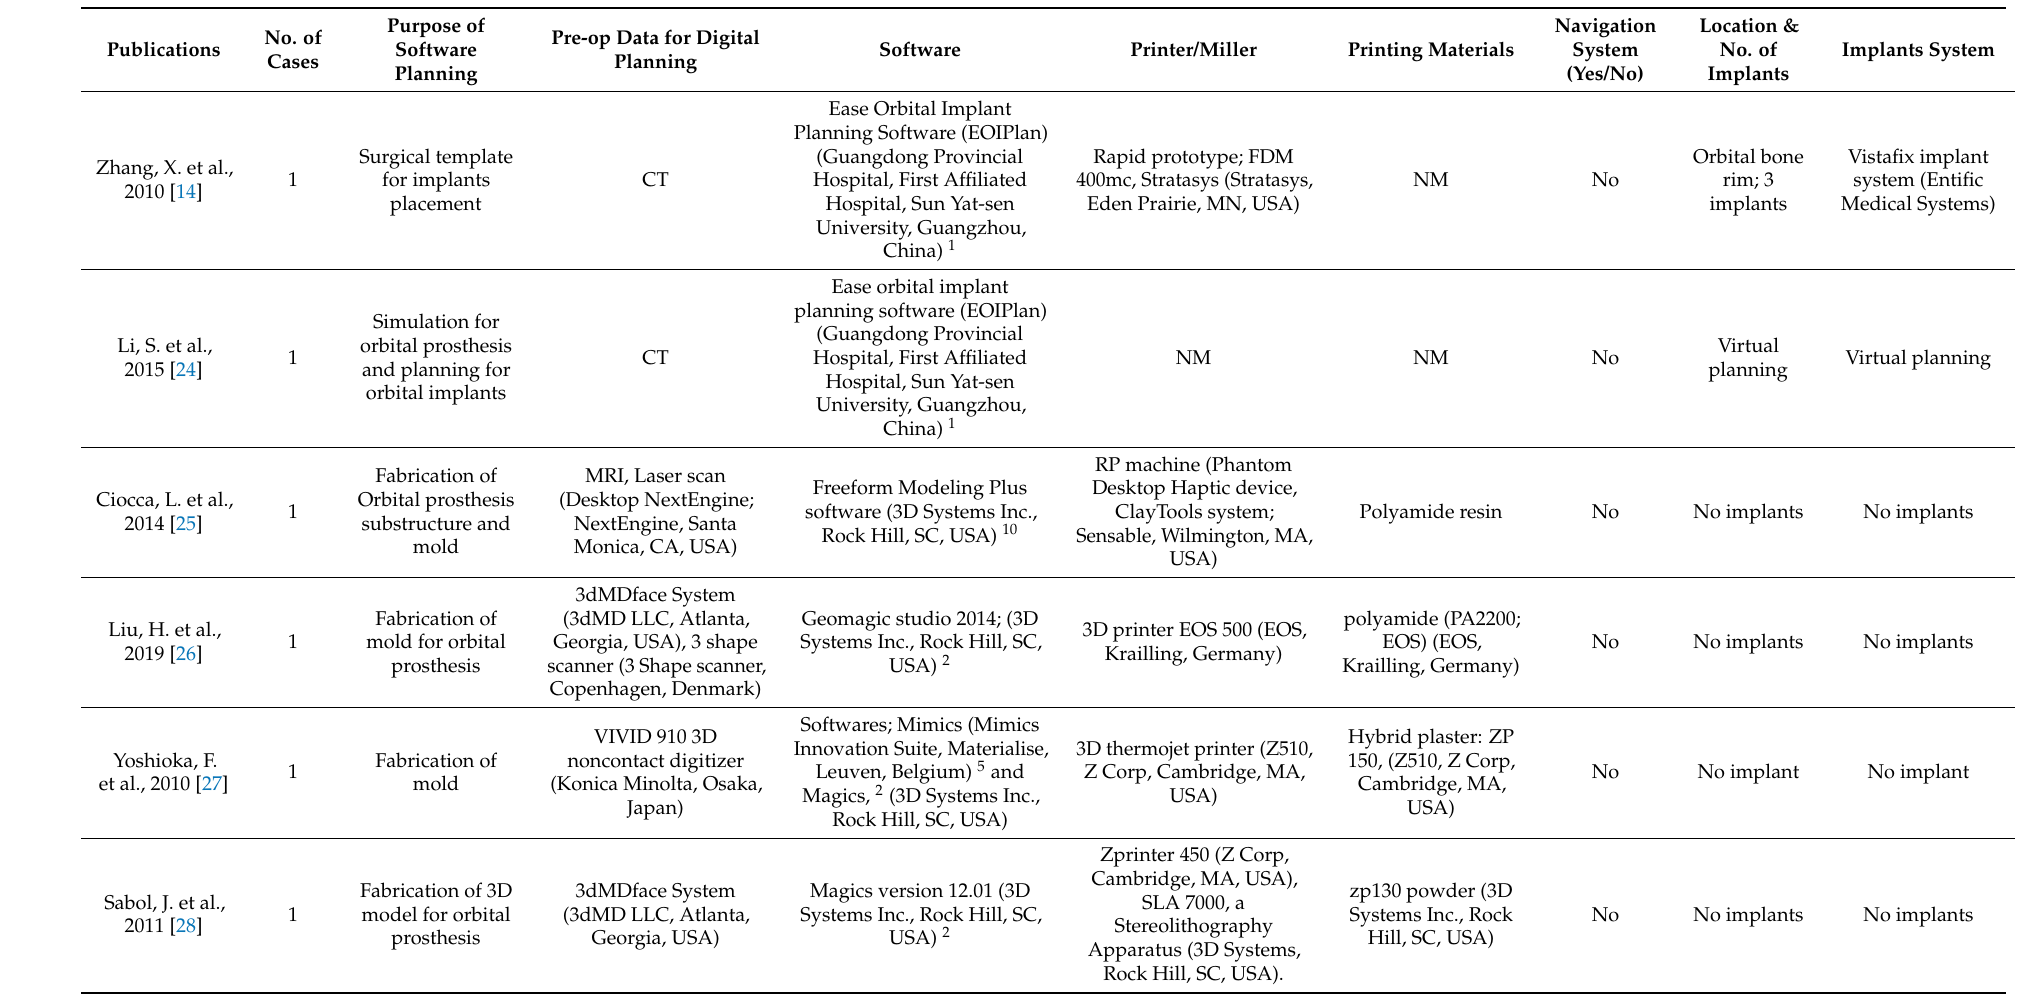
Table 1. Digital planning for the prosthetic rehabilitation of orbital